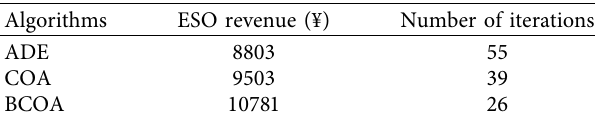
Table 5: Te optimization results of diferent